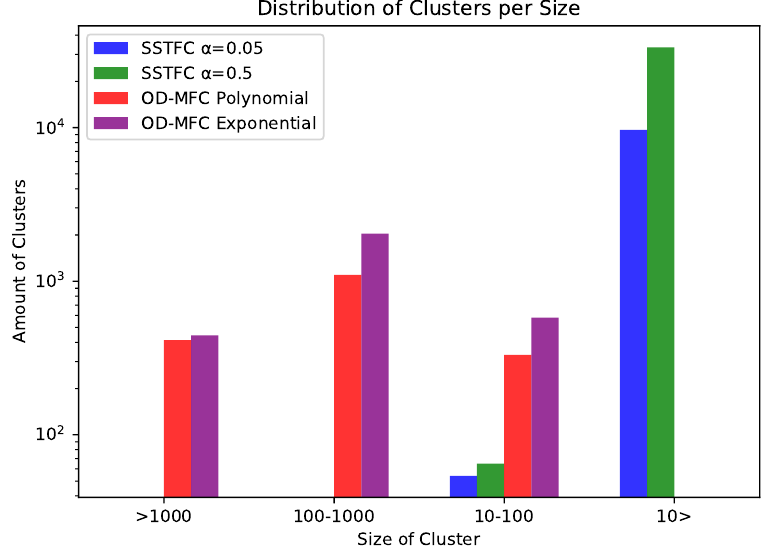
Figure 7. Distribution of flow clusters according to their